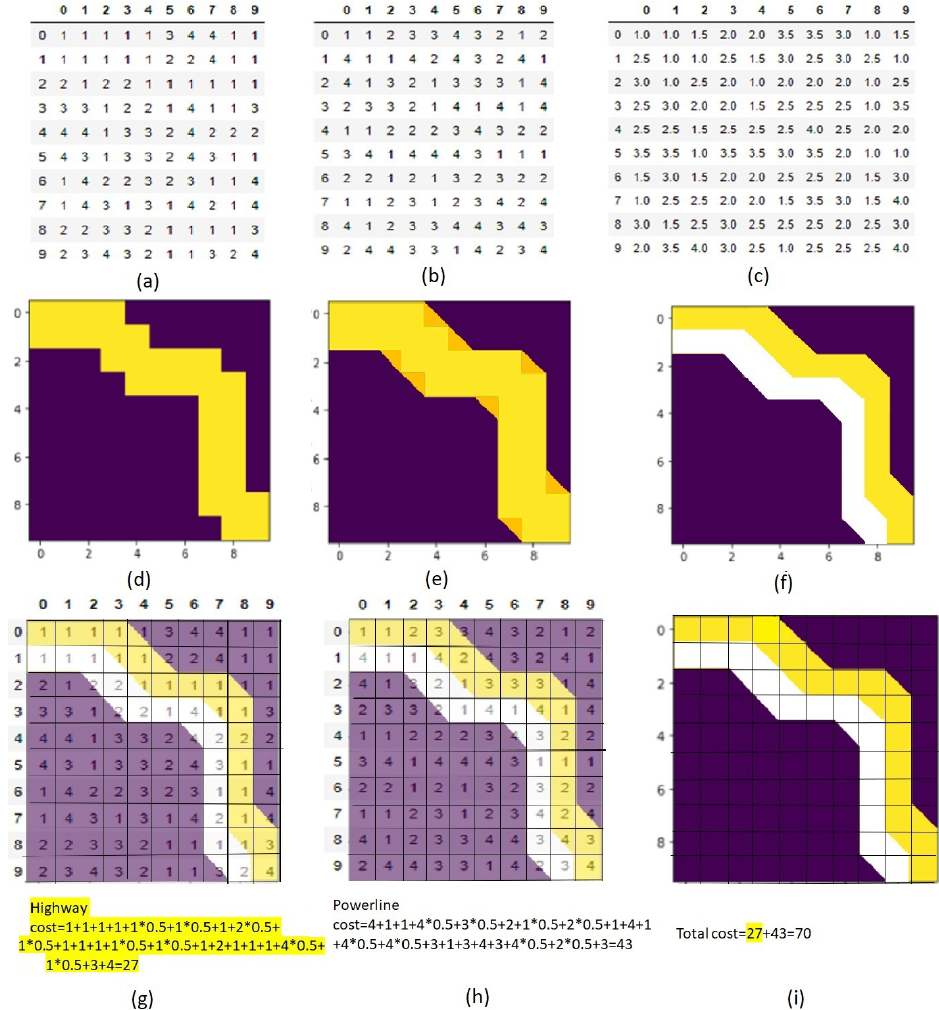
Figure 15. Subfigure ( a ) is highway cost layer, using cost raster values in line with [28]). Subfigure ( b ) is the power line cost, data created randomly. Subfigure ( c ) is the average cost raster of Subfigures ( a , b ). Subfigure ( d ) is the two-cell-wide LCP method [27]. In Subfigure ( e ) some triangles are added to Subfigure ( d ) to make the width constant. In Subfigure ( f ), the space within Subfigure ( e ) is divided between two modes with the first mode in yellow and the second mode in white. In Subfigures ( g , f ) is overlaid on Subfigure a to calculate the cost of the highway. In Subfigures ( h , f ) is overlaid on Subfigure ( b ) to calculate the cost of the powerline. The total cost is the summation of Subfigures ( g , h ) that is depicted in Subfigure ( i